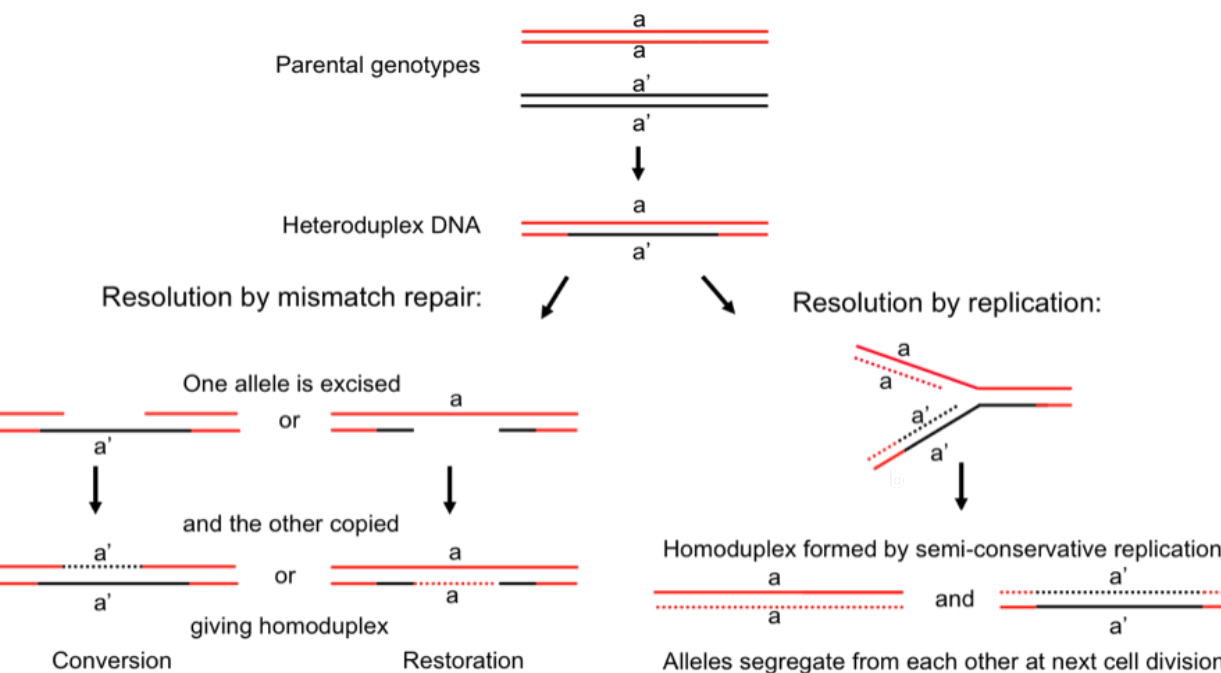
Figure 2 . Mechanisms of conversion from heteroduplex DNA. Recombination forms hybrid DNA molecules with two complementary strands from different sources, shown here as a length of black (donor) sequence in the red recipient molecule. If there is an allelic difference (a or a’), the hybrid molecule is called heteroduplex. Heteroduplex is subject to mismatch repair (left) by which a length of one strand including the mismatch is excised and replaced by copying the other strand. If the recipient (red) strand is excised, the recipient molecule will be converted to the genotype of the donor (black). If the donor sequence is excised, the genotype of the recipient molecule will be restored. Heteroduplex DNA can also be resolved by replication (right) resulting in conversion in one of two daughter cells. Each line represents a single strand of DNA. New synthesis is shown as a dotted